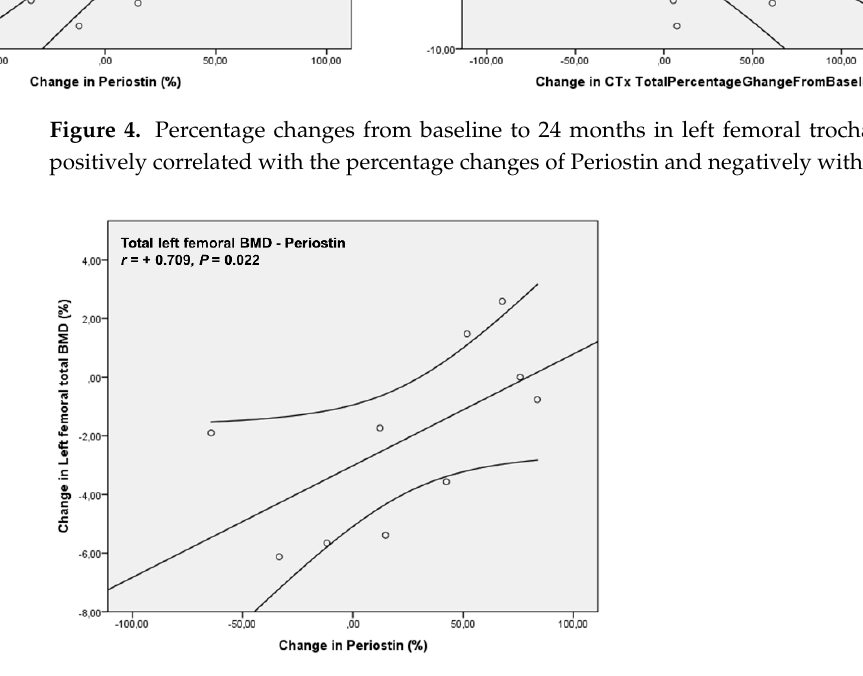
Figure 5. Percentage changes from baseline to 24 months in total left femoral BMD were positively correlated with the percentage changes of Periostin levels.